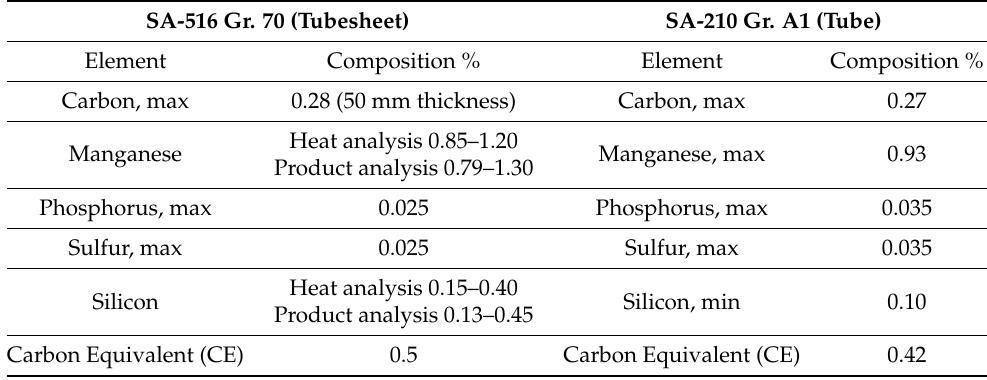
Figure 5. Dimensions (in mm) of header boxes. Table 1. Chemical composition of materials